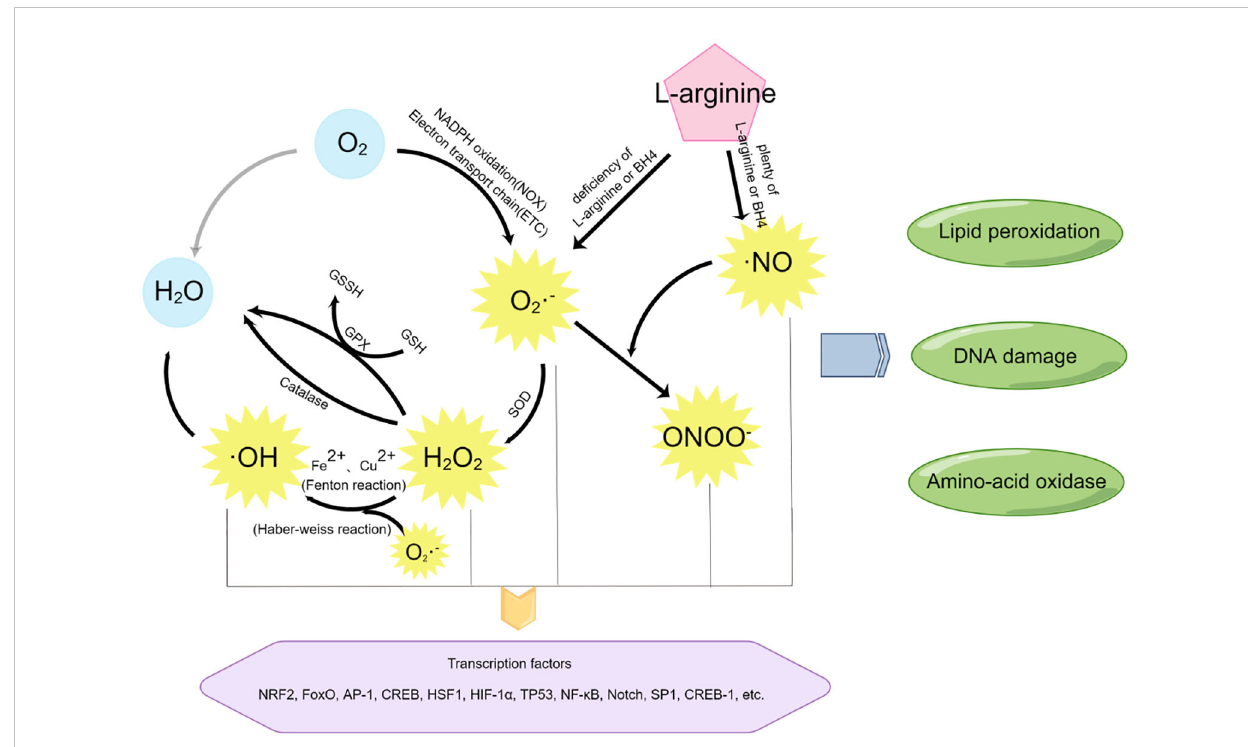
FIGURE 3 The mediators of oxidative stress and nitri fi cation stress and their related reaction pathways. By